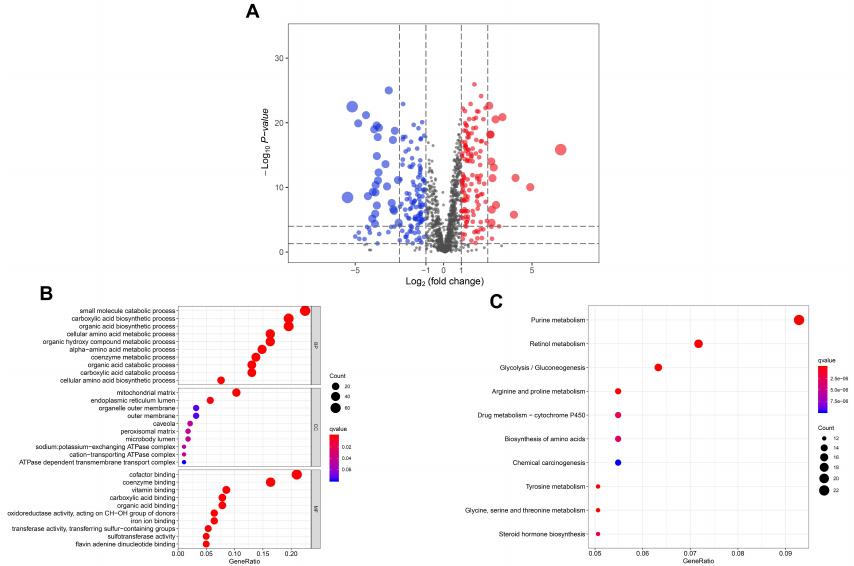
Figure 1. The significantly altered metabolic enzymes in The Cancer Genome Atlas (TCGA) head and necksquamouscellcarcinoma(HNSCC)cohort. ( A )VolcanoplotofmetabolicenzymesbetweenHNSCC tissues and normal tissues. Y -axis indicates the p values (log 10 -scaled), whereas the X -axis indicates the fold change (log 2- scaled). Each symbol represents a di ff erent metabolic enzyme. The red and blue color indicates the significantly upregulated and downregulated metabolic enzymes, respectively. ( B , C ) Gene Ontology (GO) and Kyoto Encyclopedia of Genes and Genomes (KEGG) analysis of the significantly altered metabolic enzymes.